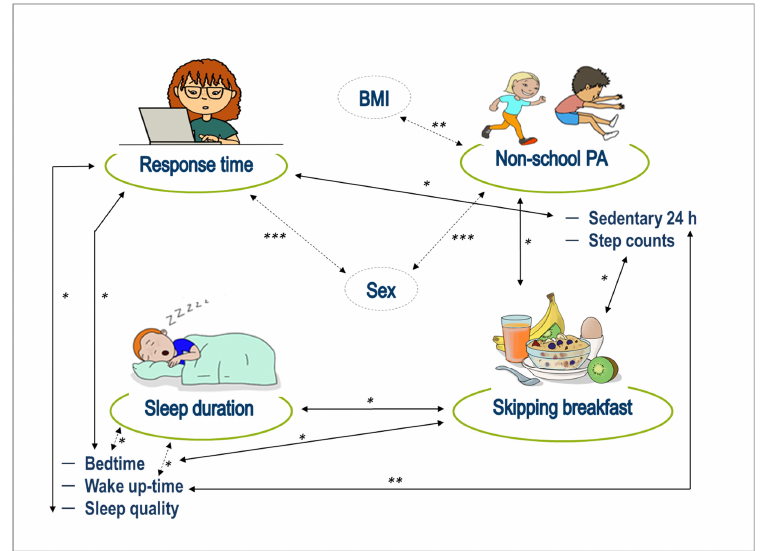
Figure 2. Relations between the studied variables based on the Kruskal–Wallis test and Spearman’s rank correlation coefficient. Skipping breakfast and non ‐ school PA were entered as categorical variables; response time in the Visual Attention Task, step counts, sedentary, sleep duration, bedtime, wake up ‐ time, and BMI were entered as continuous variables. Sex and sleep quality were entered as dichotomous variables. The arrows show significant correlations between behavioral characteristics. BMI = Body Mass Index, PA = physical activity. * p ≤ 0.05, ** p < 0.01, *** p < 0.001. There was a positive correlation between wake up ‐ time and sedentary behavior ( p = 0.006, r = 0.188), suggesting that children who were more sedentary woke up later on the test day. Other characteristics of sleep and PA did not correlate ( p > 0.05). 3. Results The participants’ characteristics are presented in Table 1. On average, 10.9% ( n = 24) of the children did not eat breakfast at all before going to school and 6.3% ( n = 14) did not do sports outside school. The children slept more than 9 h on average and more than 9.5% ( n = 21) of the children reported poor sleep quality. Fifty ‐ five of 221 (24.9%) children slept less than the recommended 9 h for this age group [9].